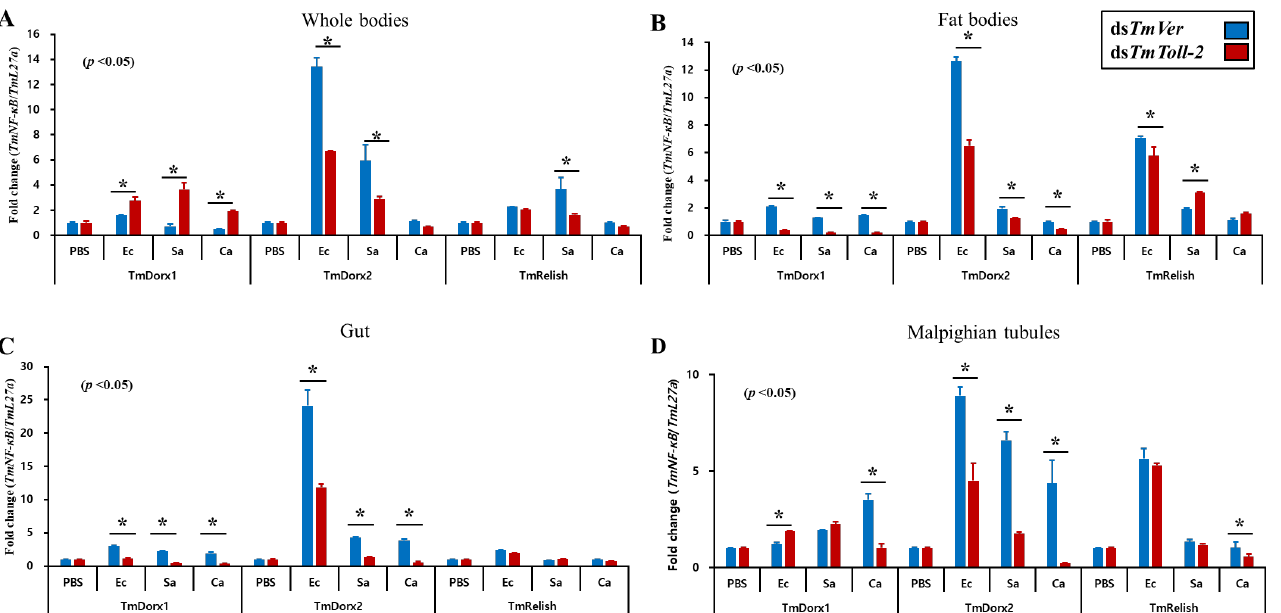
Figure 9. Effect of TmToll-2 gene silencing on NF-kB gene expression. ds TmToll-2 RNAi-treated T. molitor larvae were infected with E. coli , S. aureus , and C. albicans ; at 24 h post pathogen injection, the mRNA levels of the NF-kB pathway genes TmDorX1 , TmDorX2 , and TmRelish in the whole body ( A ), fat bodies ( B ), gut ( C ), and Malpighian tubules ( D ) were measured via RT-qPCR. The expression level of TmDorx2 was suppressed following E. coli and S. aureus infection in all the examined tissues, while the level of TmRelish was not affected. In the fat bodies and gut, the NF- κ B genes expression was negatively regulated. TmVer dsRNA was assessed as a negative control, and T. molitor ribosomal protein ( TmL27a ) was used as an internal control. All experiments were performed in triplicate. Asterisks indicate significant differences between ds TmToll-2 - and ds TmVer RNAi-treated groups determined using Student’s t -test ( p < 0.05).